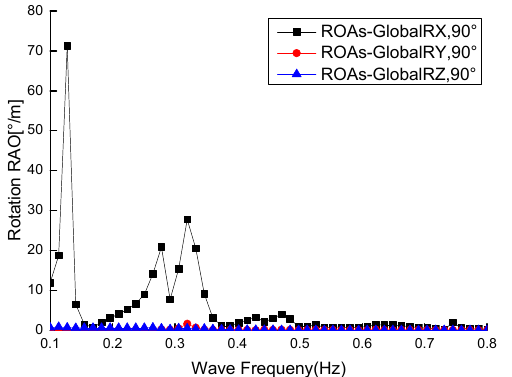
Figure 5. The way the value of the RAO in the RX, RY, and RZ directions varied with wave fre- quency.